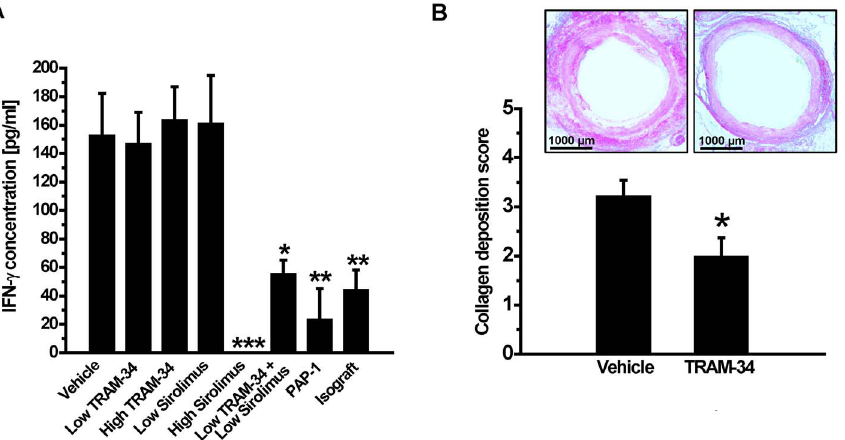
Figure 6. (A) PAP-1, high dose sirolimus and the combination of low dose sirolimus and low dose TRAM-34 strongly reduce circulating IFN- c levels. IFN- c levels in pg/ml on day-120 after transplantation: Vehicle (153.0 6 29, n=8); low-dose TRAM-34 (147.3 6 21.6, n=7); high-dose TRAM-34 (163.89 6 23, n=6); low-dose sirolimus (161.4 6 33.7, n=6); high dose sirolimus (not detectable, n=5); low-dose TRAM-34 plus low-dose sirolimus (55.7 6 9.4, n=6, p=0.01), PAP-1 (23.8 6 21.3, n=6, p=0.001); isograft (44.6 6 13.6, n=6, p=0.006). (B) TRAM-34 reduces collagen deposition. Representative images of Sirius red stained aortic grafts harvested 120 days after transplantation from vehicle and TRAM-34 treated rats and collagen deposition score from of aortic grafts from vehicle (3.22 6 0.32, n=8) and high-dose TRAM-34 treated rats (2 6 0.37, n=6, p=0.045).